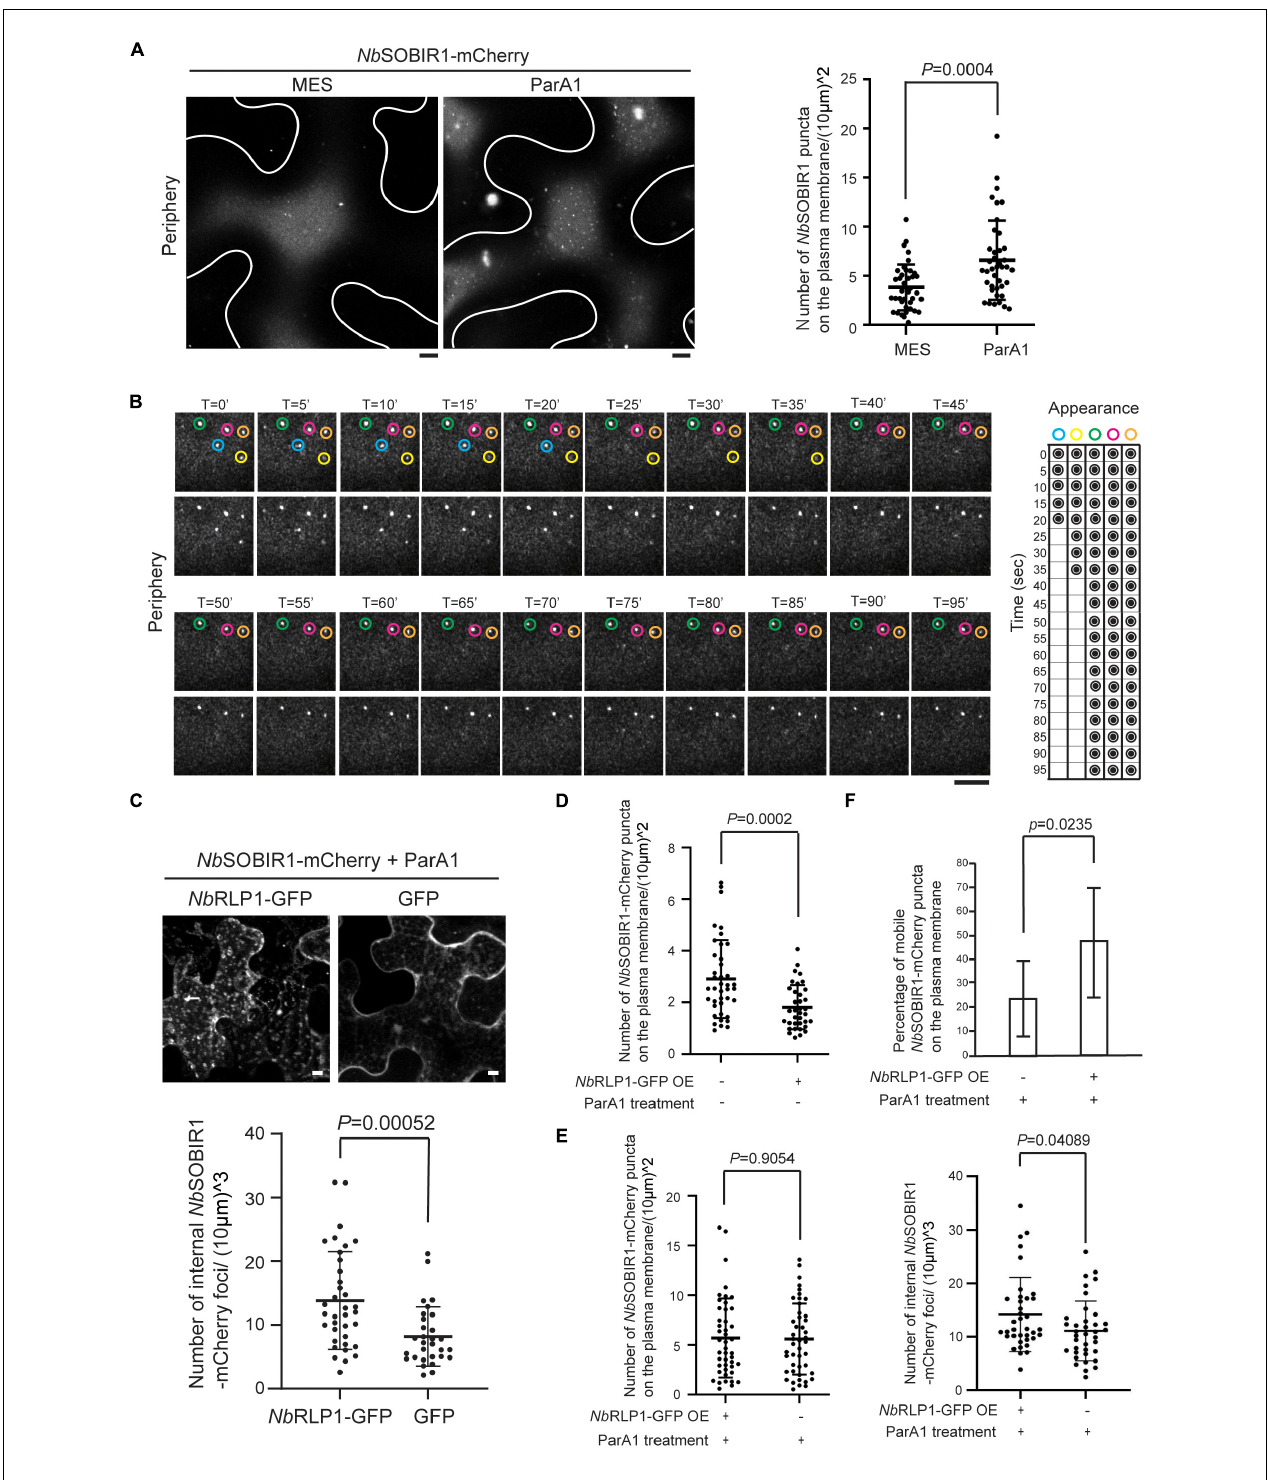
FIGURE 6 | Nb RLP1-GFP overexpression promotes Nb SOBIR1-mCherry endocytosis upon ParA1 elicitin treatment. (A) Nicotiana benthamiana leaves expressing Nb SOBIR1-mCherry were infiltrated with MES buffer alone (control) or 0.3 µ MParA1 in MES buffer. After 30 min, the leaves were subjected to microscopy, focusing only on the periphery of the leaf epidermal cell, using the Zeiss LSM880 confocal microscope with an Airyscan. Representative images are shown on the left panel with an outline of the cell, and the quantification data using the scatter plot is shown on the right. Statistics is carried out by the two-tailed student’s t -test and